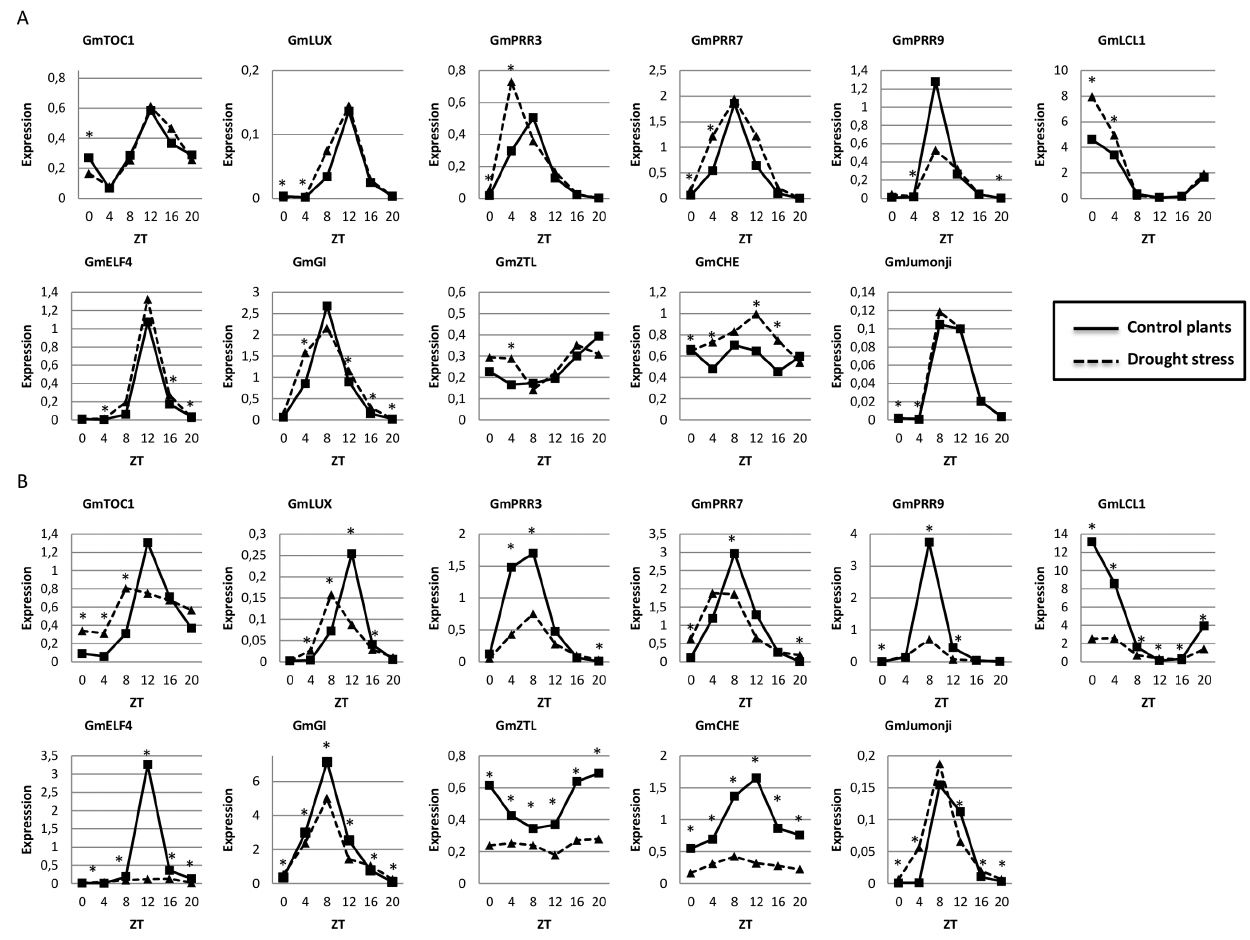
Figure 1. Drought affects the expression of some circadian clock genes in soybean. Gene expression data regards qPCR analysis of soybean leaves during moderate (A) and severe (B) drought stress. Expression axis represents normalized expression (NE)=2^ -(Ct experimental – Ctn) . Collect time points are represented by ZT (Zeitgeiber Time) 0 to 20, starting from the time the lights came on ( ZT0) and proceeding with 4 h intervals until ZT20. For easy viewing, asterisks represent significant differences between control and stressed plants in each time point (Duncan’s test 5%, time -treatment interaction). The ANOVA and the complete Duncan’s test results are presented in Table S3.